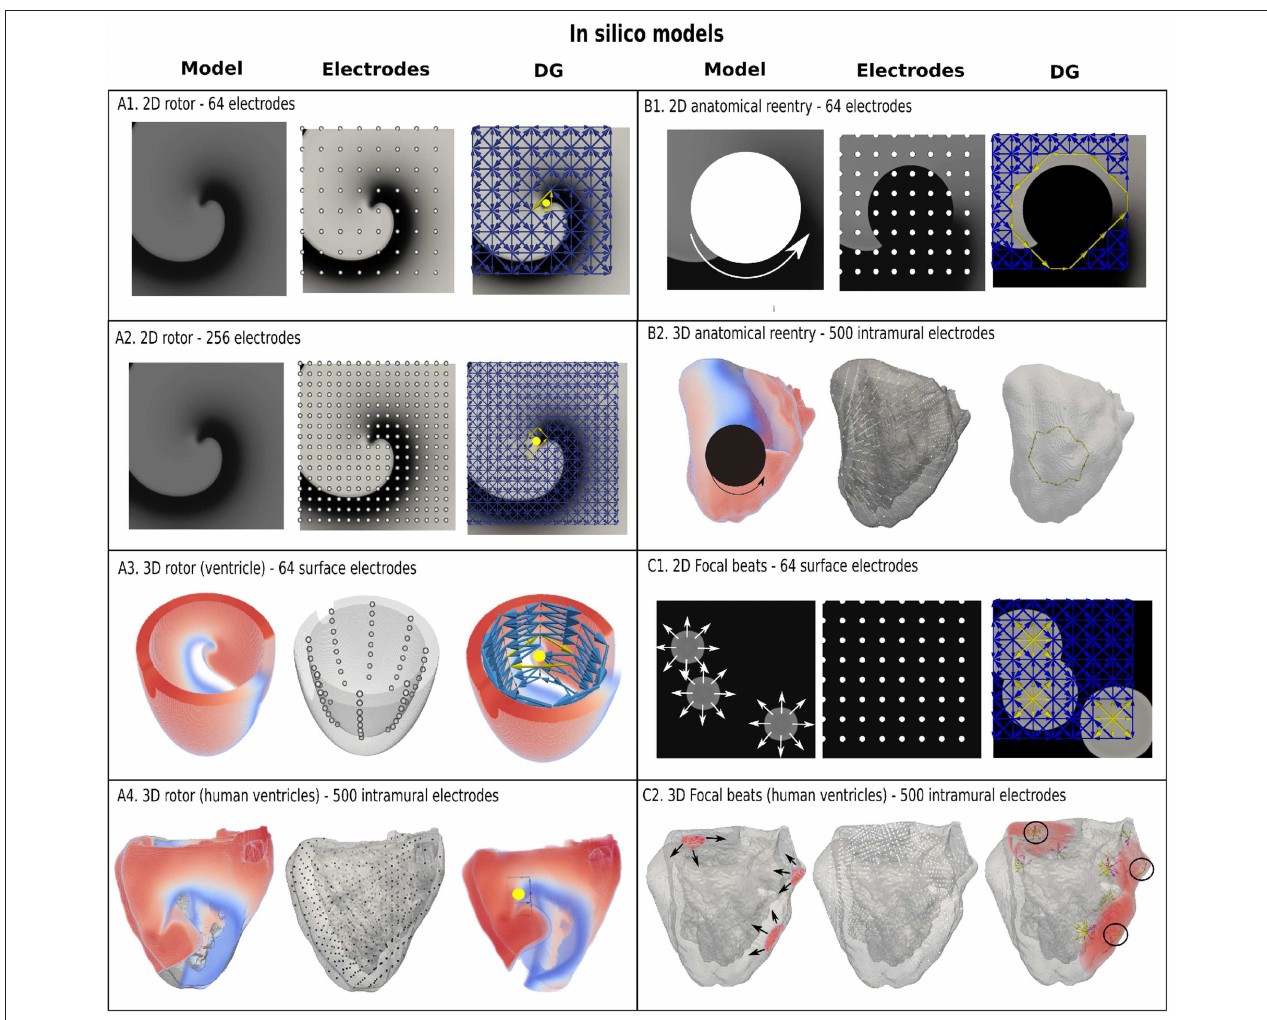
FIGURE 4 | Examples of DG mapping for different in-silico models. Model (A1,A2) show a rotor in 2D with 64 and 256 electrodes. Model (A3) shows a rotor in a simplified model of the ventricle with 64 surface electrodes. Model (A4) depicts a rotor in an anatomical model of the ventricles with 500 intramural electrodes. The smallest cycles and their geometrical center are indicated in yellow. Model (B1) depicts anatomical reentry in 2D with 64 electrodes and Model (B2) in a model of the human ventricles with 500 intramural electrodes. The smallest reentry loop around the obstacle is again depicted in yellow. Model (C1) represents 3 focal sources in 2D with 64 electrodes, whereby DG mapping shows the sources in yellow. Similar results with 3 focal beats in the ventricles are shown in model (C2) , indicated with 3 black circles. In addition, the edges of the moving wavefronts are also found by DG mapping, see model (C2) , which depend on the time the graph is